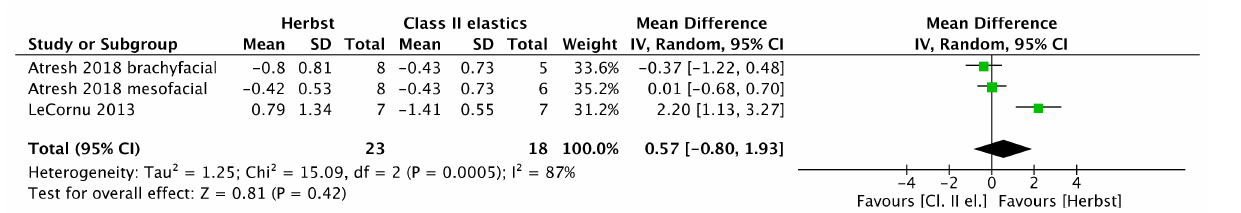
Figure 24. Forest plot of right posterior glenoid fossa anteroposterior changes using the random effects model [43,44].